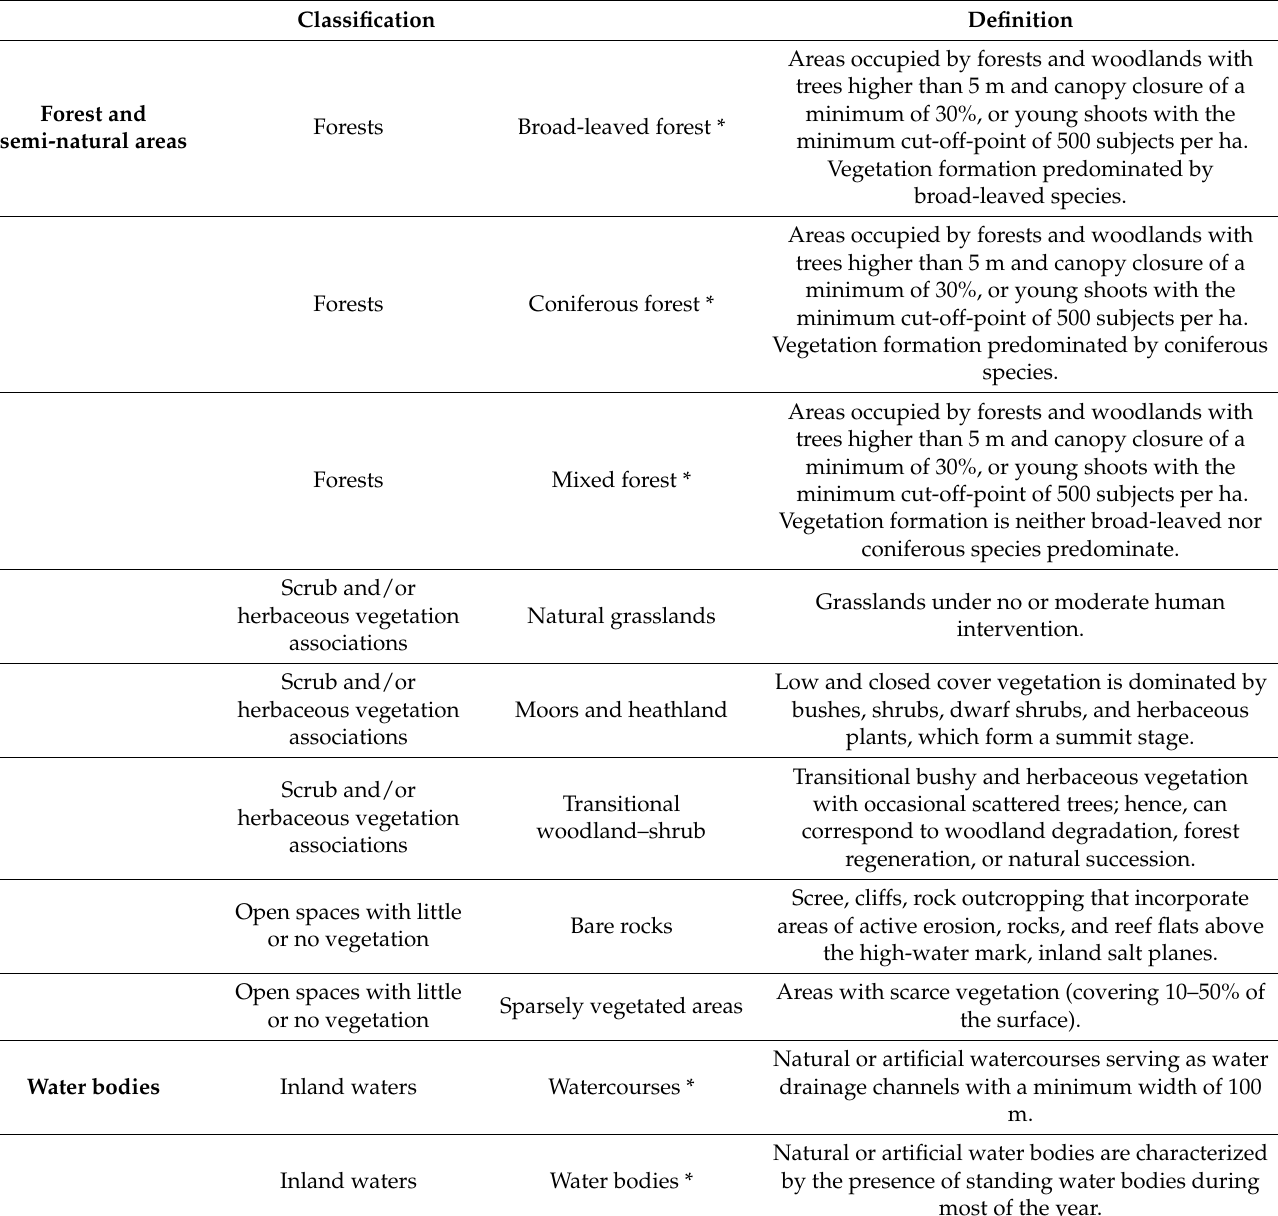
Table 1. Summary of the CLC of forest and semi-natural areas in the Czech Republic, modify from CLC Nomenclature